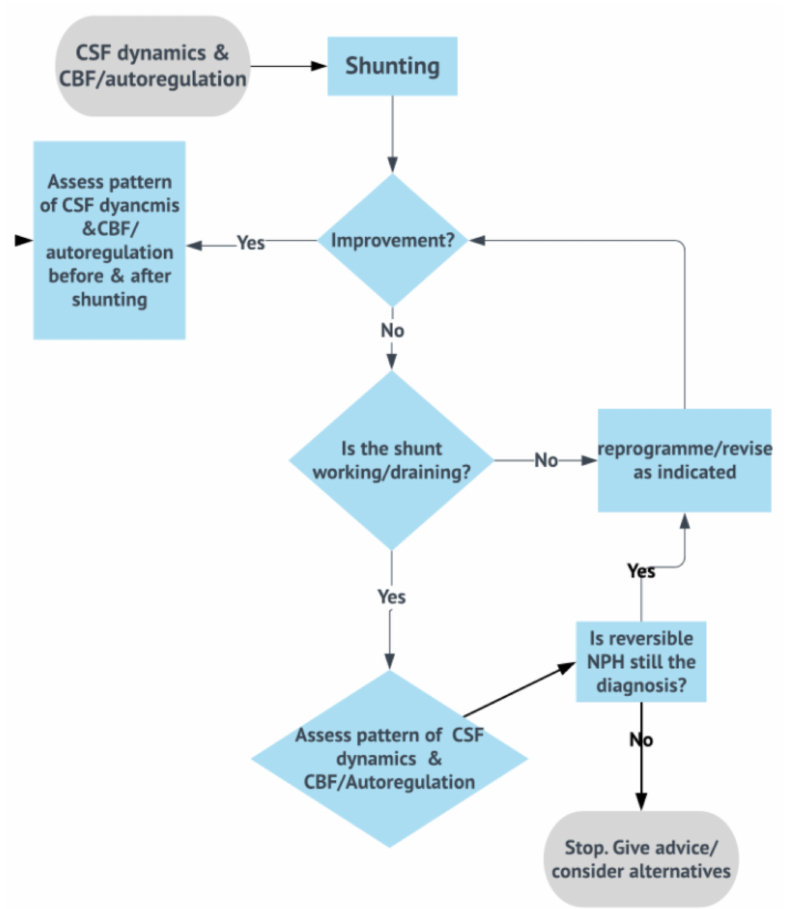
Figure 14. Summary of CSF dynamics testing applied to the bedside. This is a summary of lessons learned from testing CSF dynamics (on its own or combined with cerebrovascular markers) in shunted patients. Main methodological and physiological applications involve understanding and testing cerebral circulation using objective and feasible methods. It also requires understanding that shunt implantation involves understanding how shunt’s function influences success of intervention. This algorithm by no means represents any clinical recommendation, as there are currently no trials to validate our highlighted scientific